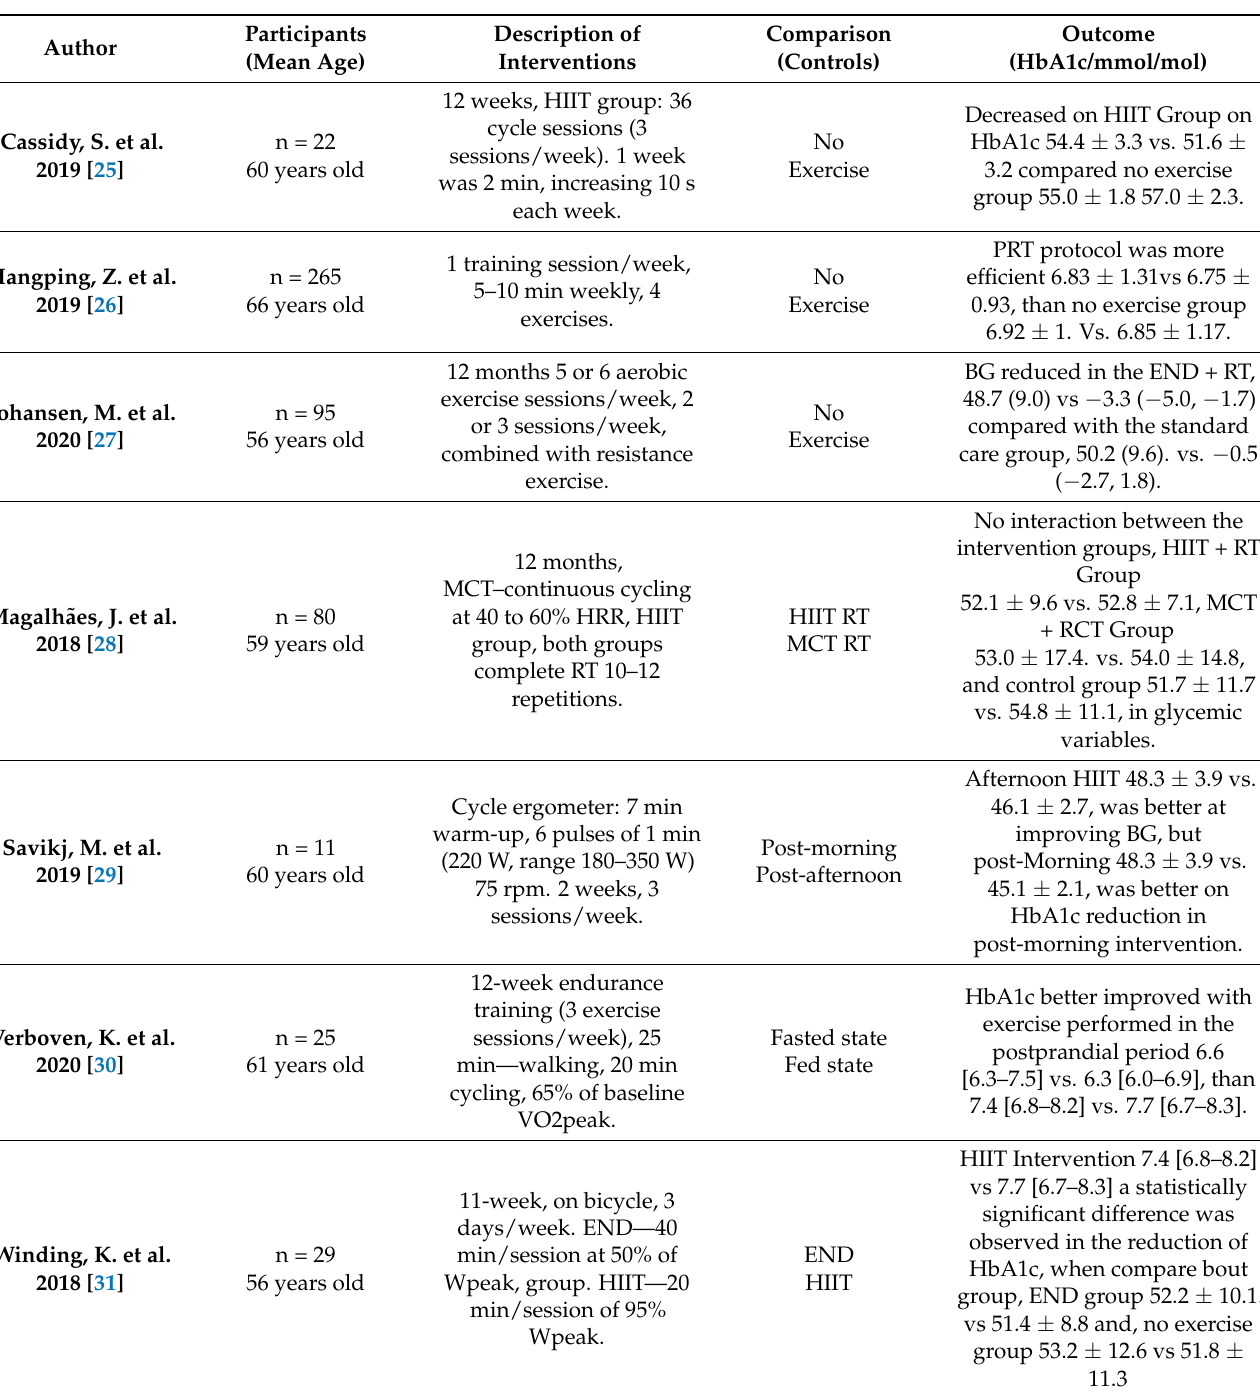
Table 2. Summary of included studies according PICO